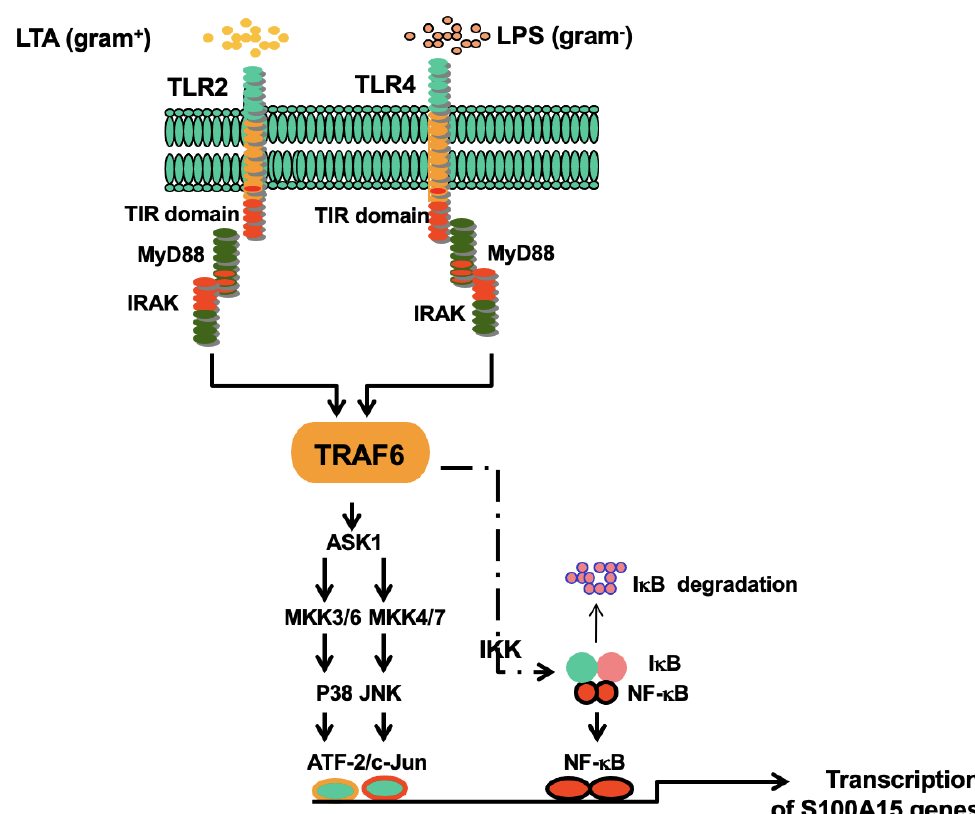
Figure 8. Proposed model for the mechanisms whereby the gram − and gram + bacterial pathogens induce the expression of the antimicrobial protein, S100A15, in the oral mucosa. The colonization of gram − and gram + bacterial pathogens result in the activation of both TLR4 and TLR2, respectively. As a consequence, TRAF6 plays a central role in mediating TLR4 and TLR2-induced signaling to NF-kB/ASK1-JNK-AP-1/ASK1-p38-ATF-2 pathways to enhance the transcriptional activation of S100A5, which subsequently functions as an antimicrobial protein to protect oral mucosa from bacterial pathogens.